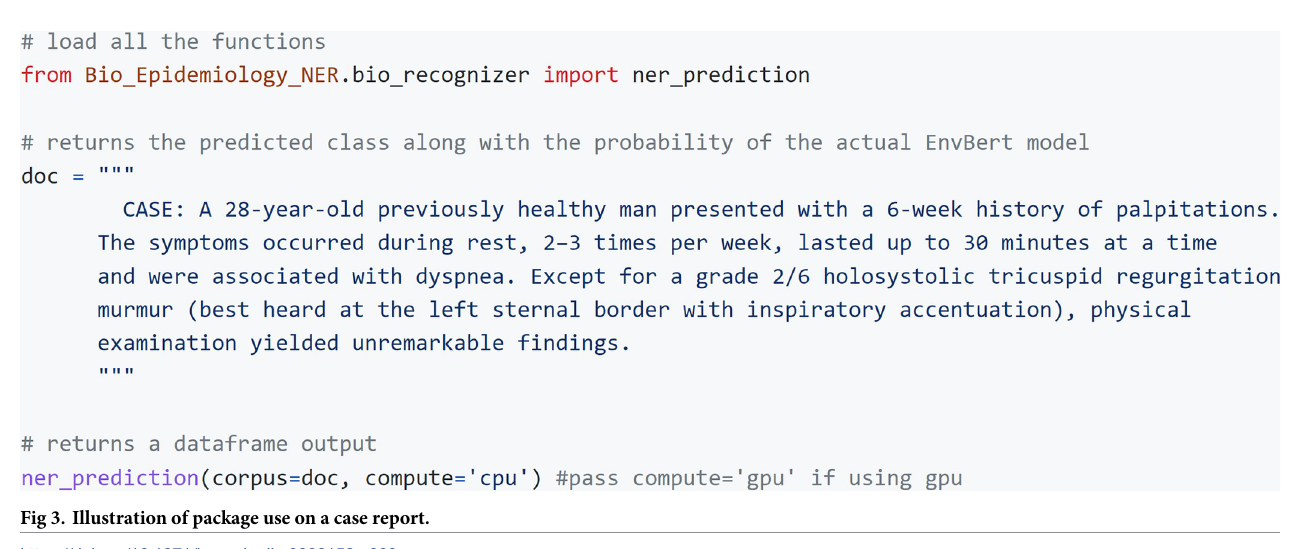
Fig 3. Illustration of package use on a case